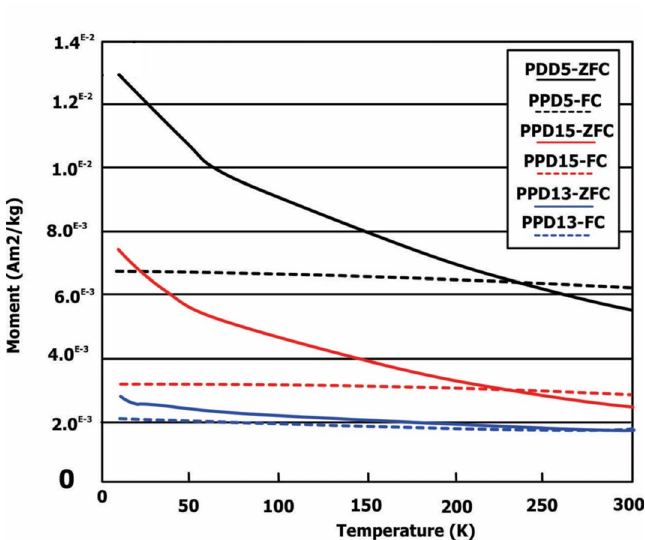
Figure A3: Low Temperature Remanence Results